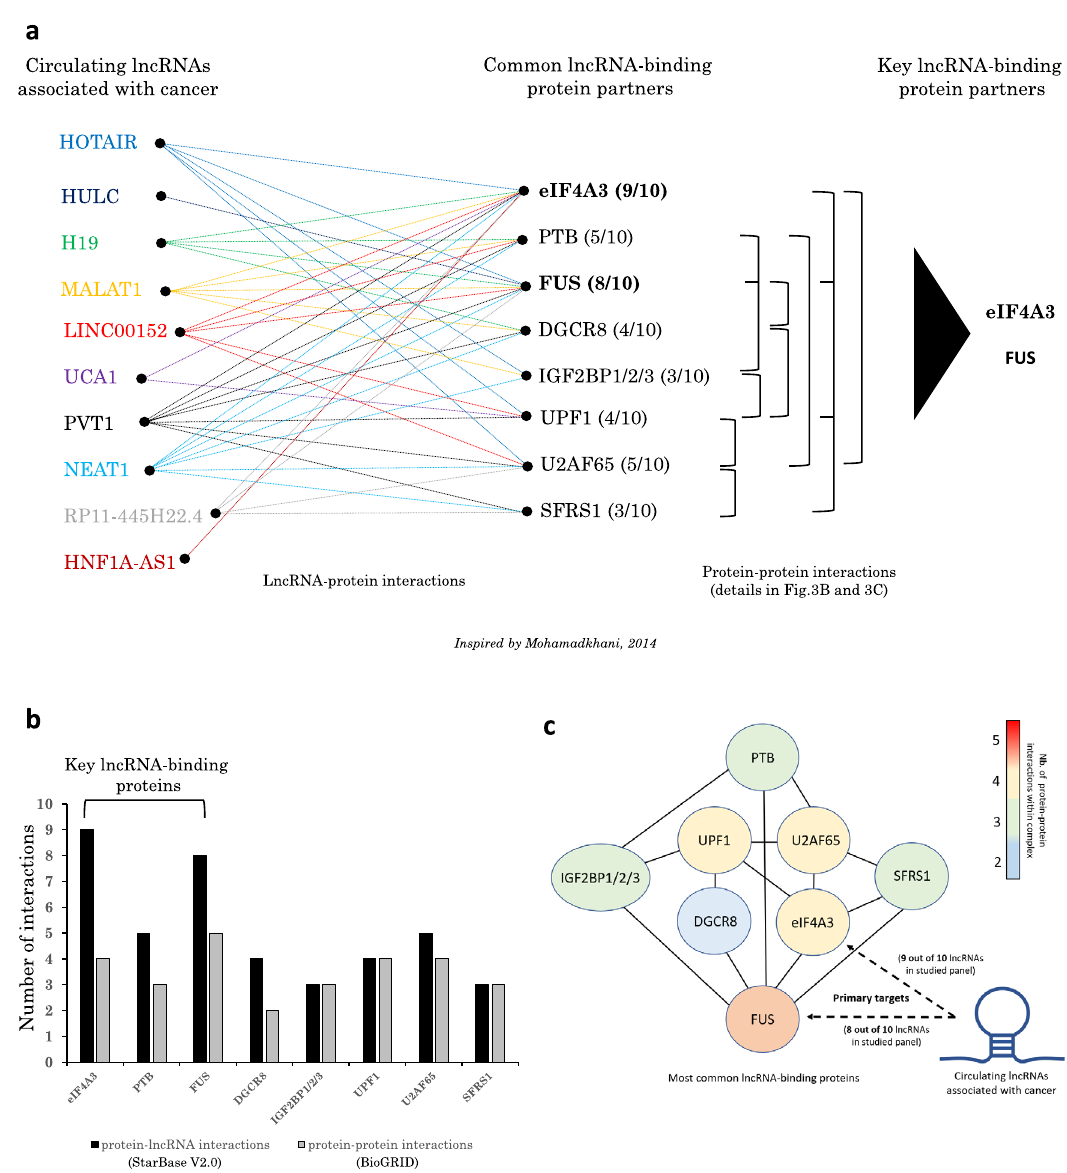
Fig. 3 Circulating lincRNAs and a common set of protein partners. a Data extracted from starBase V2.0 and lncRNome databases reporting lncRNA-protein interactions occurring in tissues. Indicated lncRNAs share the same set of interacting proteins that are also known to be involved in tumorigenesis. These main proteins may constitute an oncogenic pan-lncRNA core protein interactome. Displayed protein-protein interactions are based on data from BioGRID database. b Graph bars representing the number of interactions with lncRNAs and proteins for each RNA-binding protein shown in ( a ). c Putative pan-cancer multimeric RNA-binding protein complex showing the different interactions between the proteins that are the most commonly recruited by cancer-related lncRNAs as shown in ( a